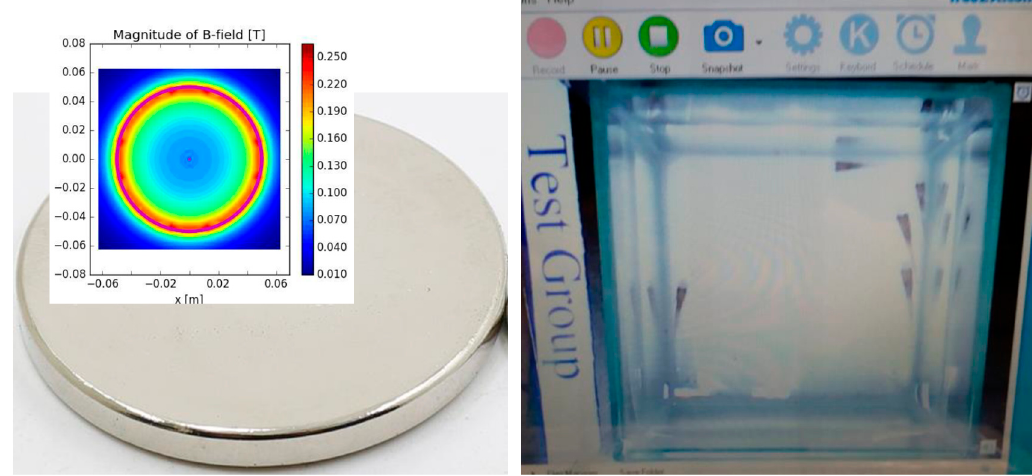
Figure 5. Illustration of the magnet and the tank keeping adult medaka fish recorded by the webcam.